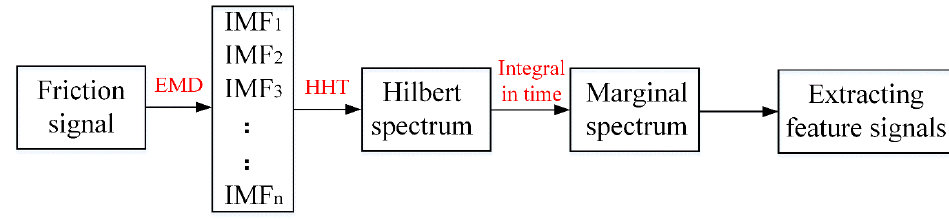
Figure 6. The feature extraction process.